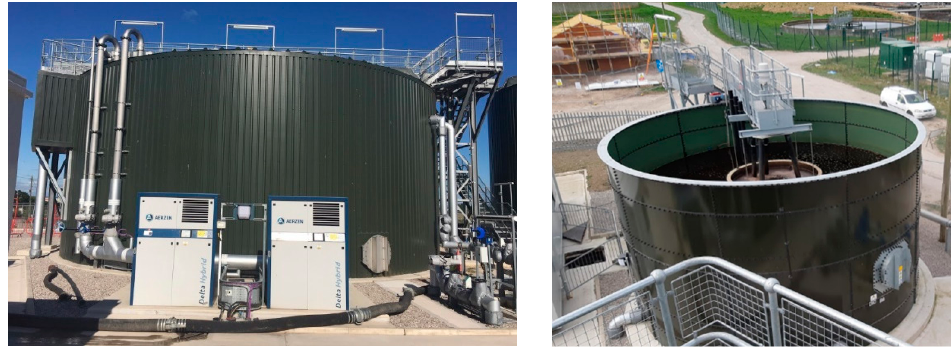
Figure 10. New IFAS ANITA Mox reactor at Wrexham ( left : IFAS tank, right : clarifier).